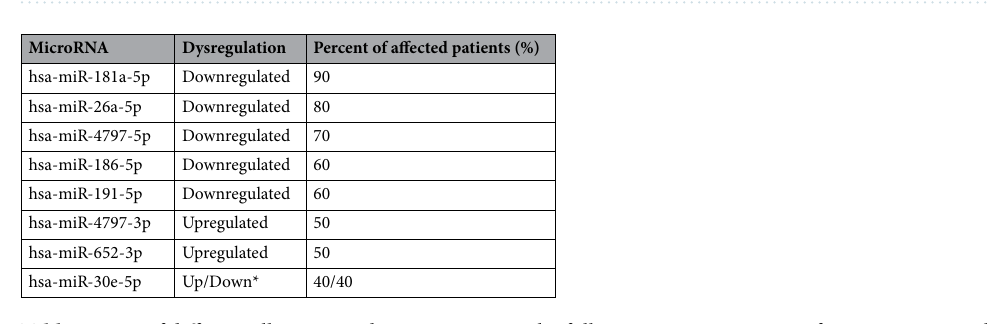
Table 4. List of differentially expressed miRNAs among the full mutation group. *40% of patients expressed downregulation and 40% upregulation.